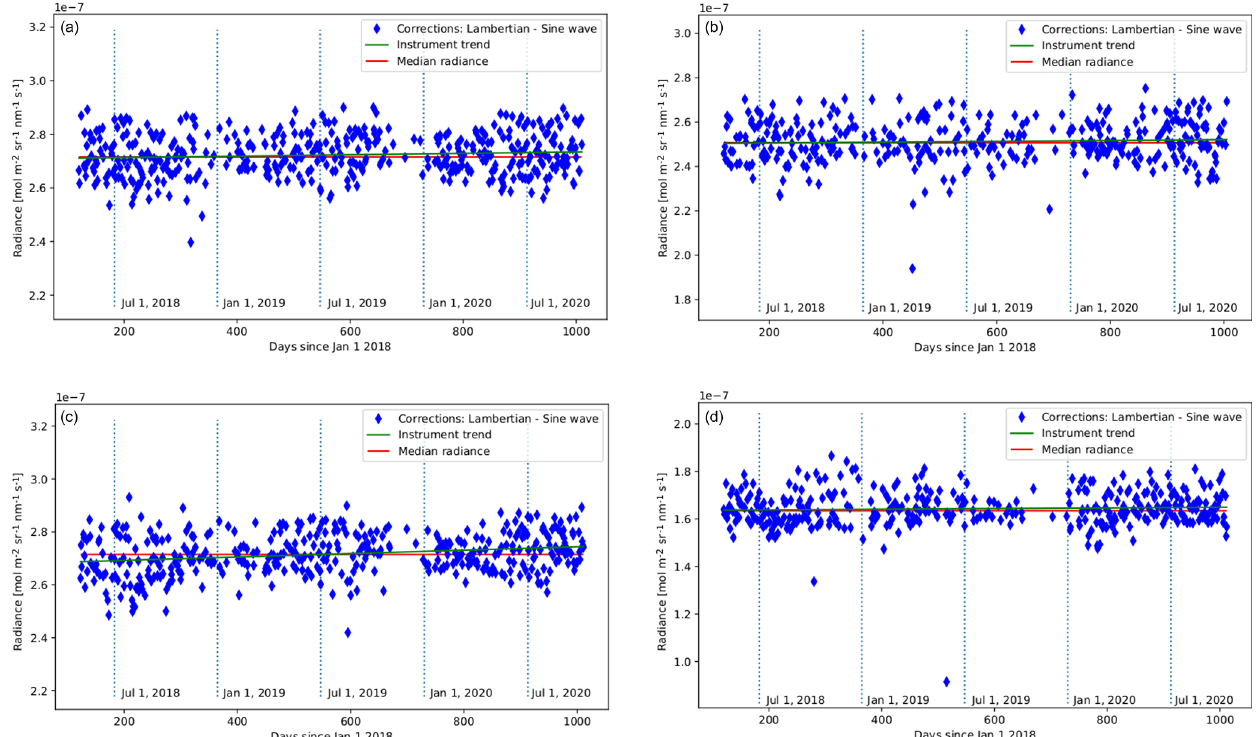
Figure 2. Continuum radiance of Egypt1 (a) , Algeria3 (b) , Libya3 (c) and NamibiaPICSAND1 (d) using a zenith angle filter of 50 ◦ . Shown are all soundings over a period of more than 1000d, starting 28th of April 2018. The median radiance (red) and a linear fit (green) are shown with lines. Data have been corrected for the solar zenith angle at each individual overpass and assuming the surface is Lambertian. A yearly variation has been corrected using a fitted sine wave with a period of 365d.